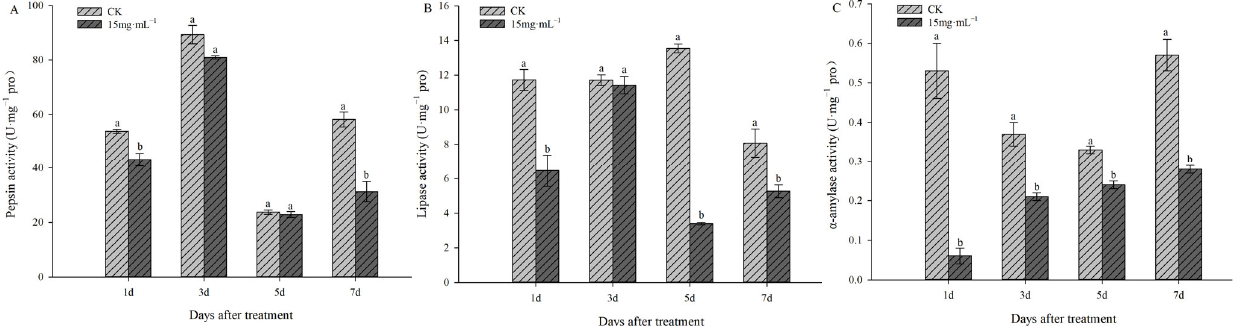
Figure 1. The impact of 15 mg · mL − 1 GSE on pepsin ( A ), lipase ( B ), and α -amylase ( C ) of M. sorghi across successive treatments. CK, 10% ethanol. Data are mean ± SE. Different letters (a, b) for the same time in each figure indicate significant differences ( α = 0.05).